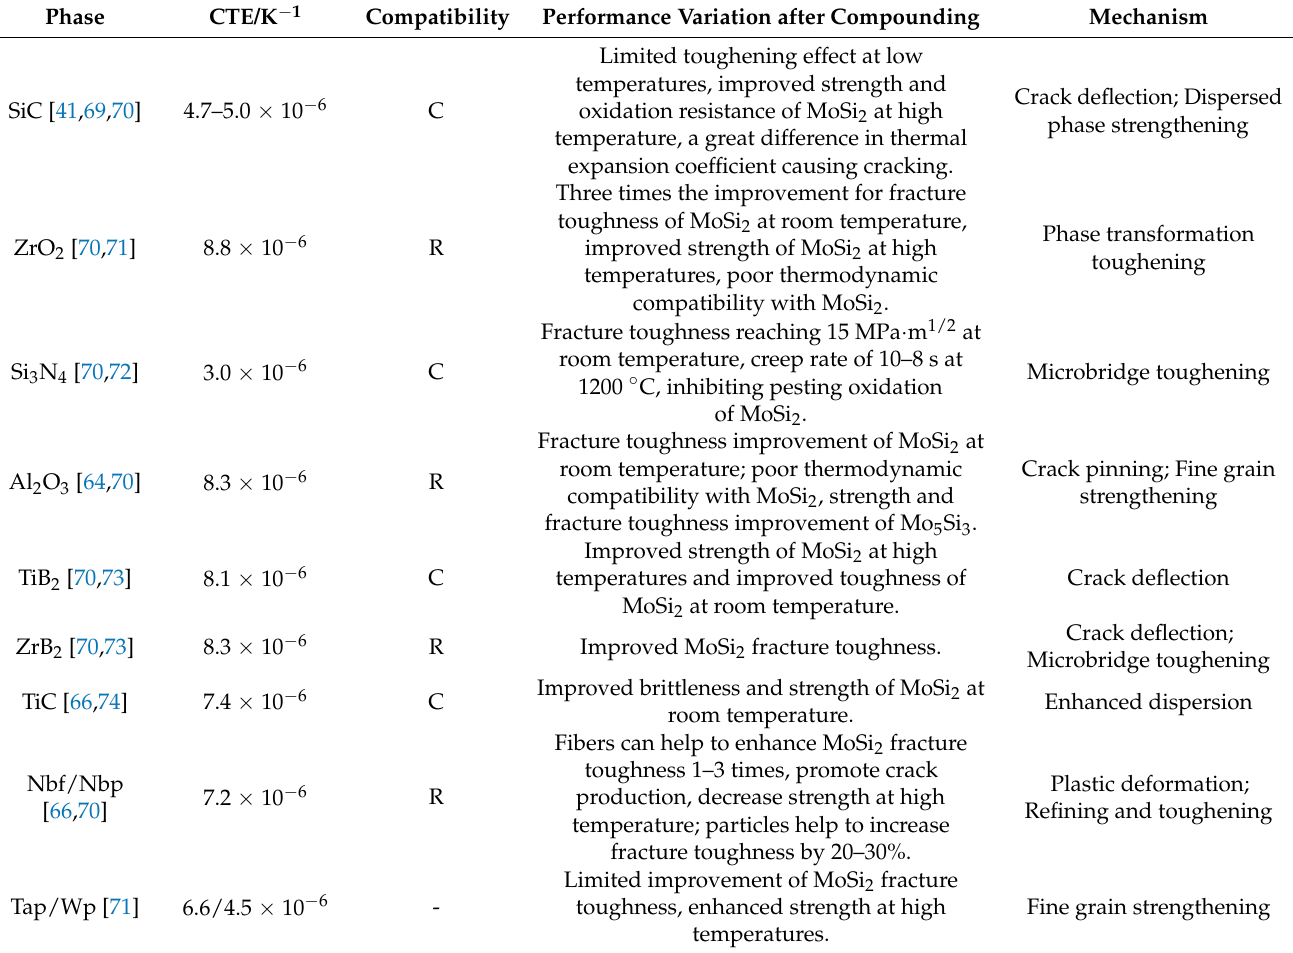
Table 8. Common reinforcement and toughening phase and some physical and chemical